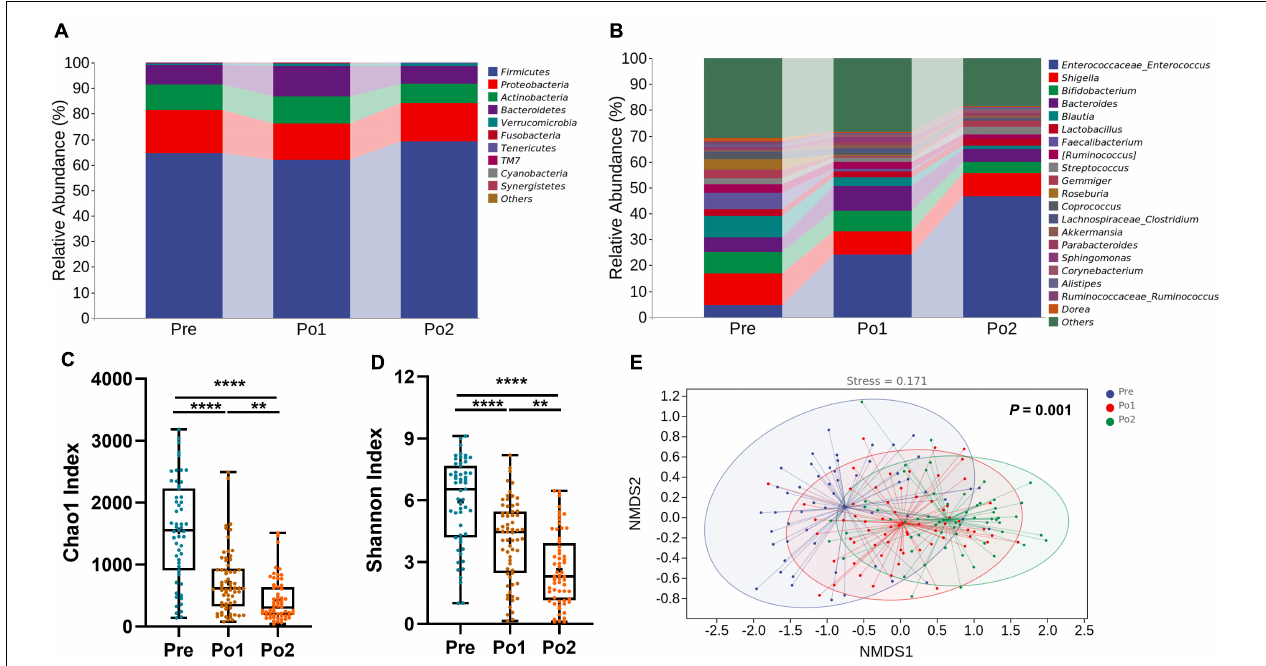
FIGURE 4 | Perioperative change of microbial taxonomy, alpha diversity, and beta diversity. Phylum (A) , genus (B) Chao1 index (C) , Shannon index (D) , and non-metric multidimensional scaling analysis (E) were assessed across time series. Statistical assessment of Chao1 and Shannon index was carried out with Kruskal–Wallis test for parametric or non-parametric data followed by post hoc test using Dunn’s multiple comparison test. Analysis of similarities (ANOSIM) was performed to test statistical differences. P < 0.05 indicates statistical significance (* P < 0.05, ** P < 0.01, *** P < 0.001, and **** P < 0.0001), and ns means P > 0.05. Results are expressed as median and